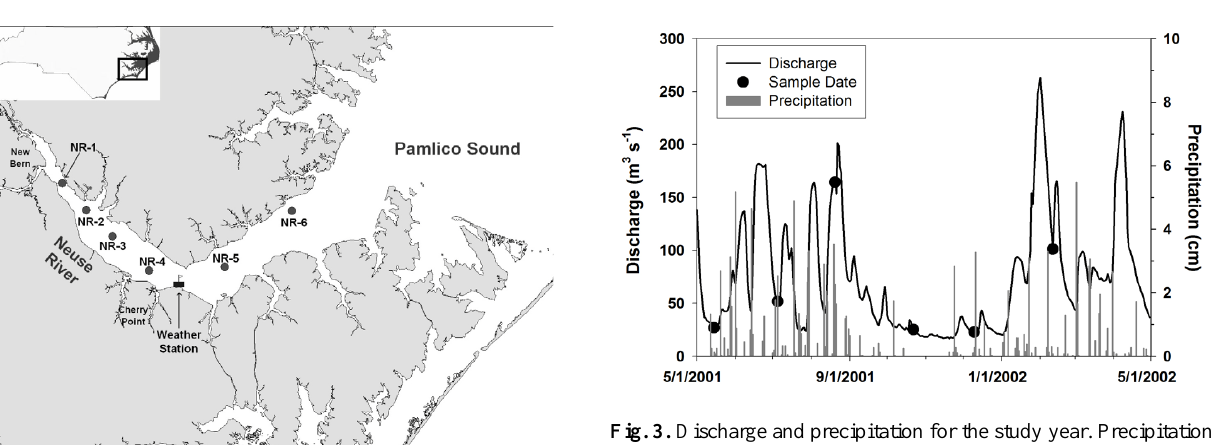
Fig. 3. Discharge and precipitation for the study year. Precipitation data is from New Bern, NC and discharge data is from the gaging station at Fort Barnwell (approximately 33km upstream from New Bern) on the Neuse River. Note that sediment removals occurred during periods of increased precipitation and river